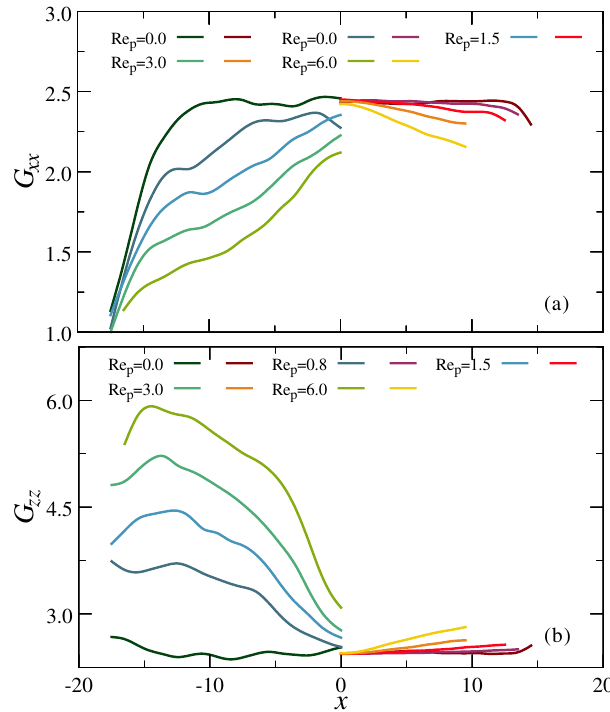
Figure 4. Components of the radius of gyration tensor along ( a ) the gradient and ( b ) the flow direction vs. the polymer CM position x . Data shown for a chain ( left ) and a star with f = 30 arms ( right ) at various flow strengths Re p , as